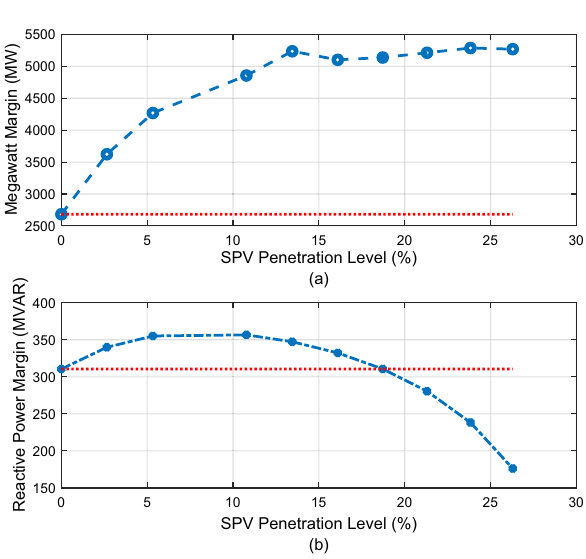
Figure 10. Variation of megawatt margin and reactive power margin with SPV